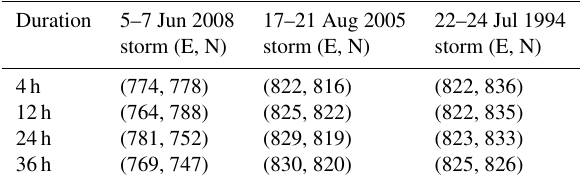
Table 2. Locations of maximum rainfall on the trend surfaces (km)